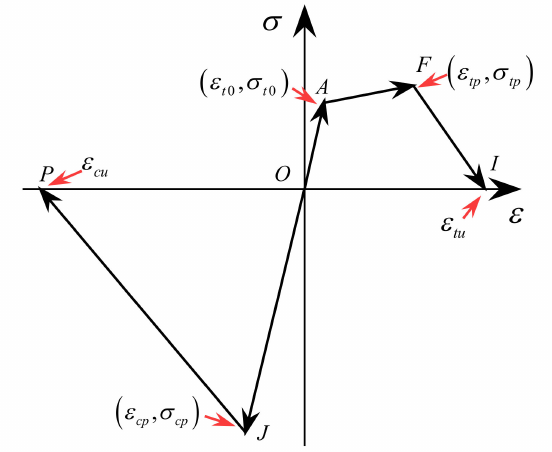
Figure 3. Envelop curves of the ECC constitutive model